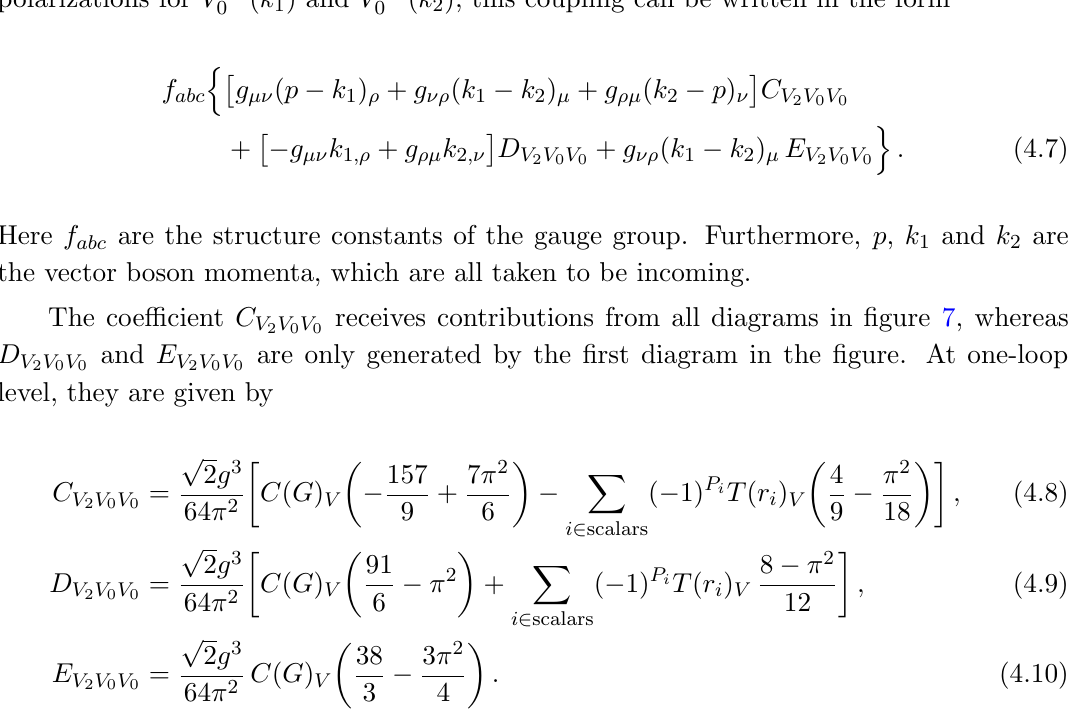
As evident from these expressions, both C and have not been previously reported in the